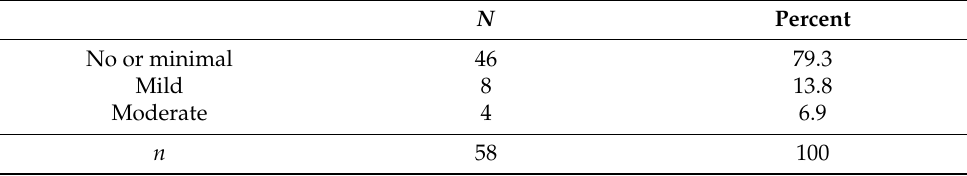
Table 5. Symptoms of depression from the PHQ-8.